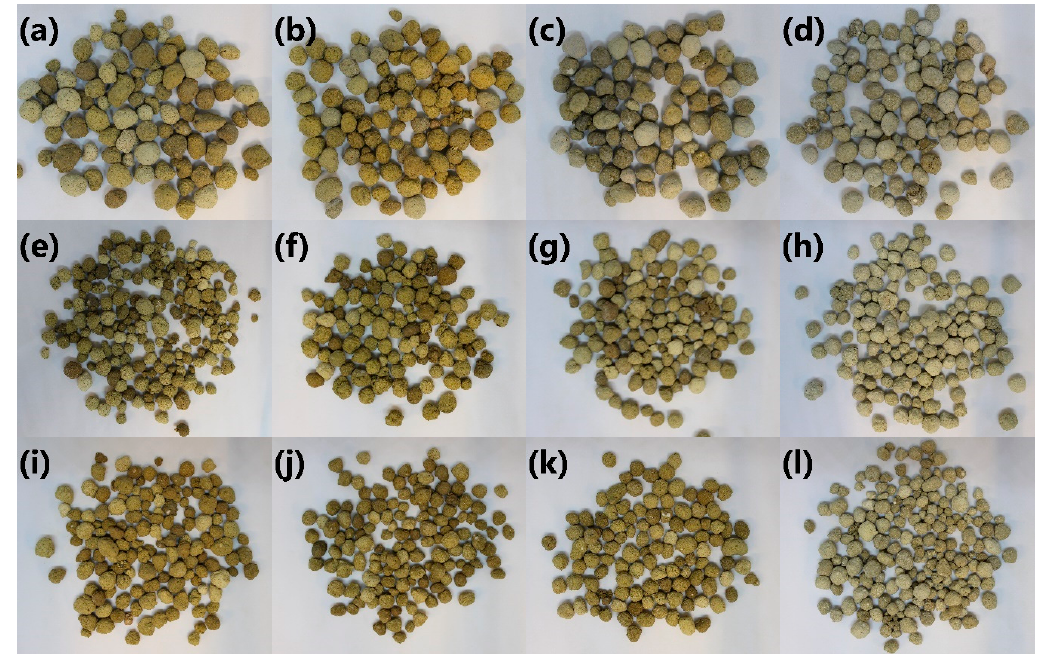
Figure 8. Appearance of ( a – d ) C 30 SS 50 , ( e – h ) C 40 SS 40 , and ( i – l ) C 50 SS 30 LWAs ( a , e , i ) initially, and after immersion in ( b , f , j ) NaCl, ( c , g , k ) NaOH, and ( d , h , l ) H 2 SO 4 solutions.